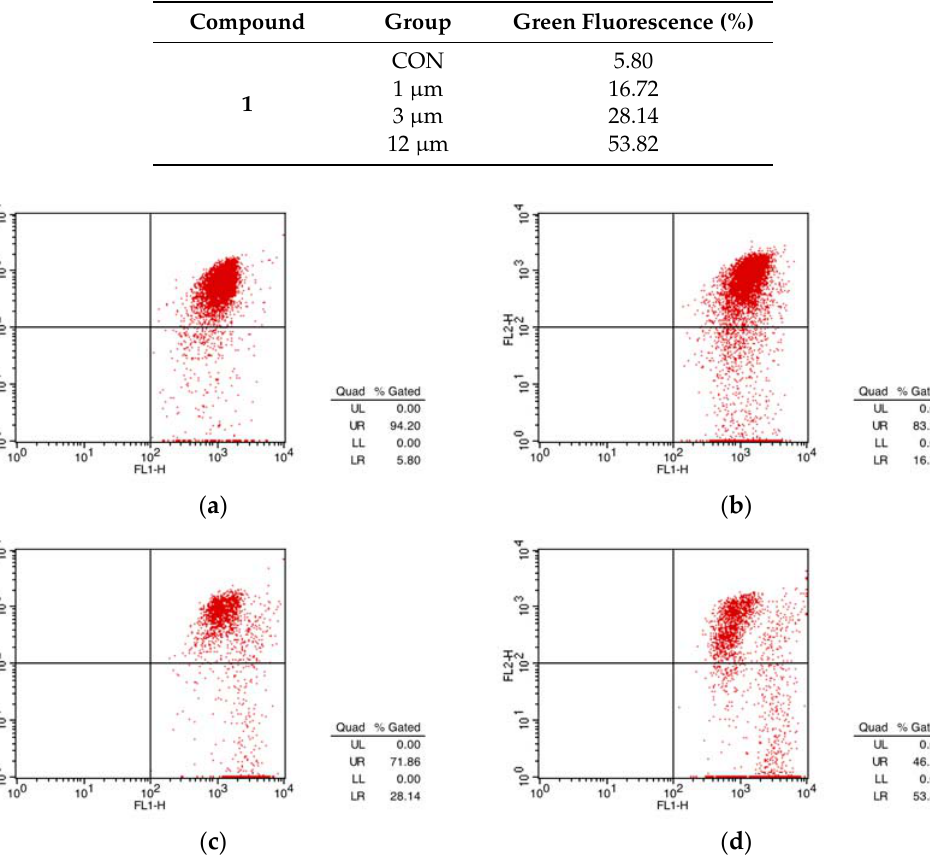
Figure 6. Effect of compound 1 on mitochondrial membrane potential in HepG2 Cells: ( a ) control group; ( b ) 1 μ M; ( c ) 3 μ M; and ( d ) 12 μ M.